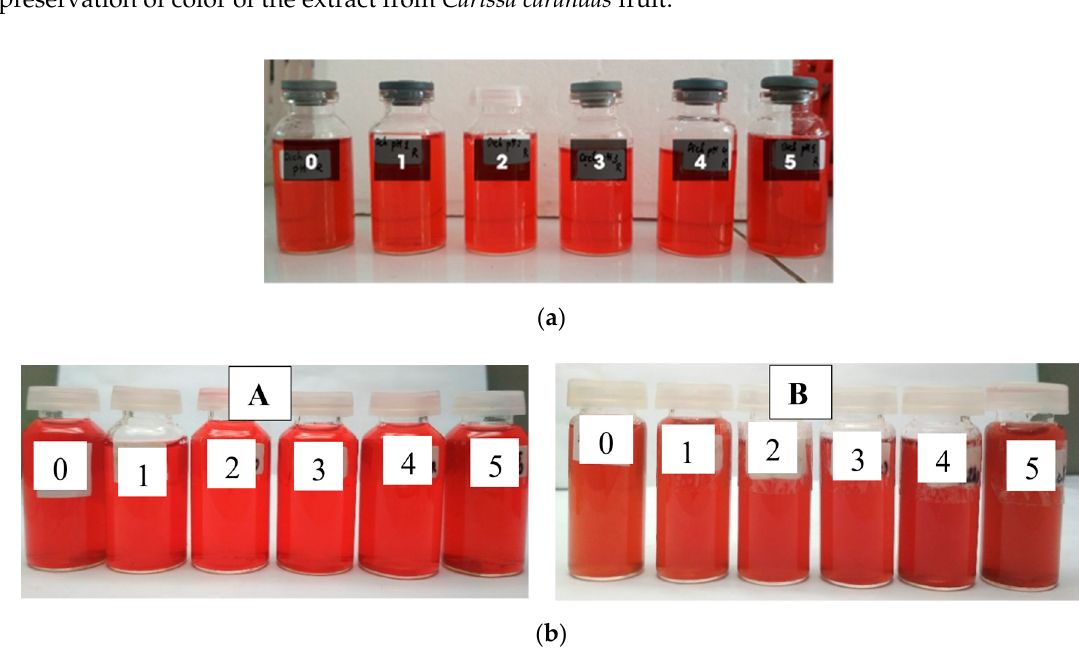
Table 2. pH level of the extraction without solvent is stabilized by citric acid.